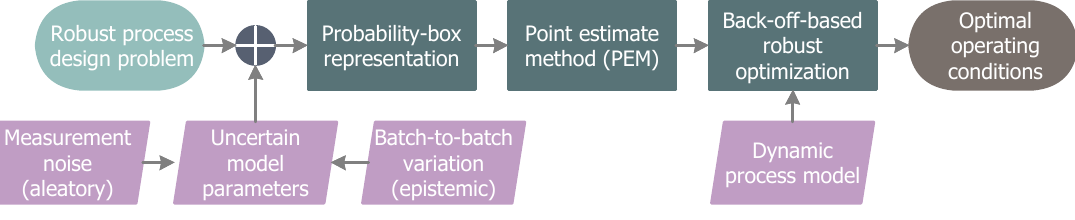
Figure 1. Flowchart of the proposed framework of robust process design under batch-to-batch